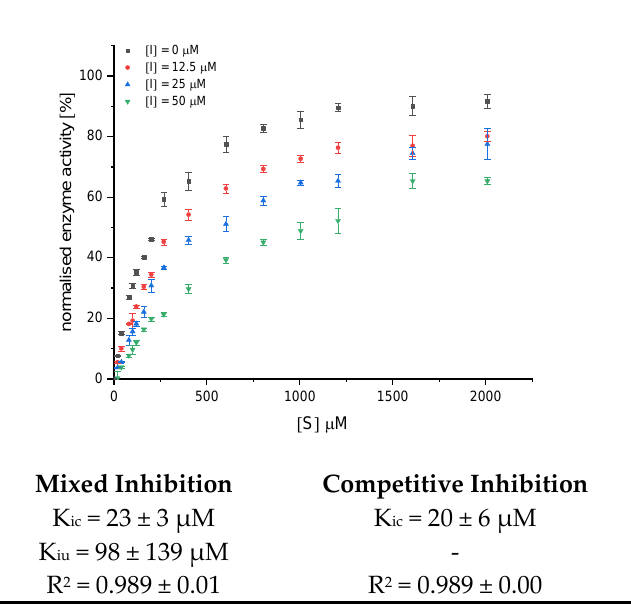
Figure 6. Decrease in conversion rate of GalG 2 CNP by addition of 12.5, 25, and 50 µM BC 4 (Cyd-gal-xyl-glc(fer)) and inhibition constants fitted according to the mixed and competitive inhibition. Abbr.: I, inhibitor; K ic , inhibition constant of the competitive part of the inhibition model; K iu , inhibition constant of the uncompetitive part of the inhibition model.